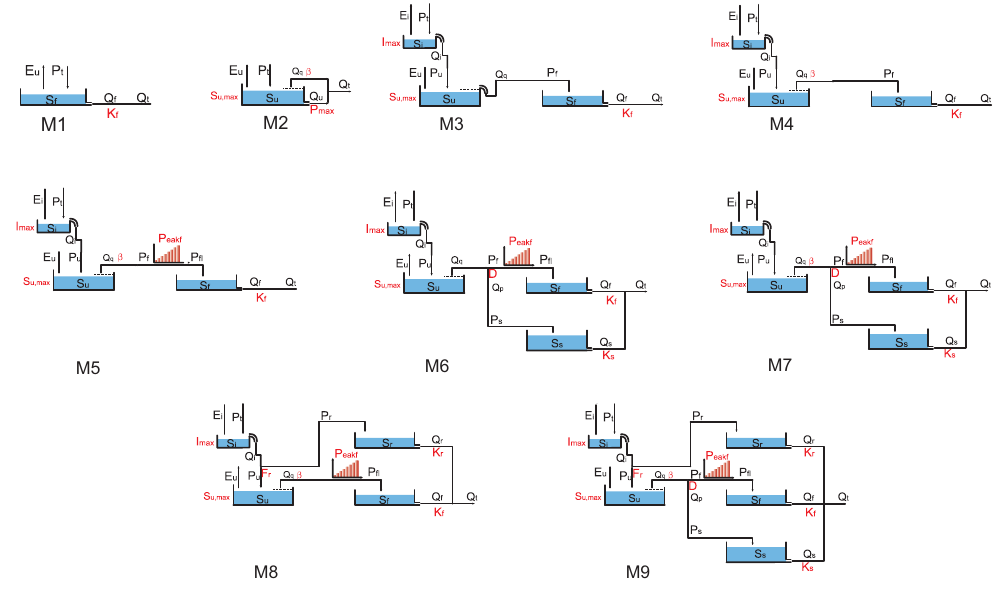
Fig. 7. Conceptual configurations of the flexible model structures used for this study. Table 3. Prior and posterior parameter ranges for both catchments for